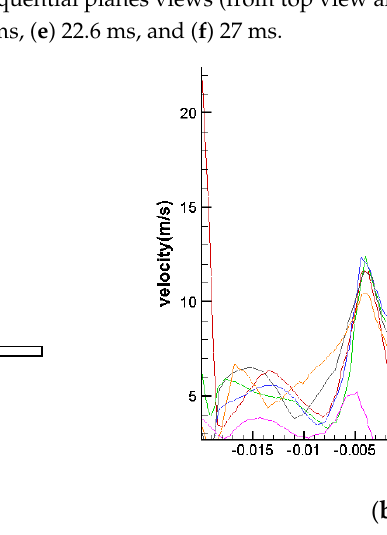
Figure 30. When inlet pressure = 15 MPa, gap = 1.5 mm, the variation of the velocity vector plot of suction cup- θ 20 with time in sequential planes views (from top view and bottom view) at: ( a ) 5 ms,